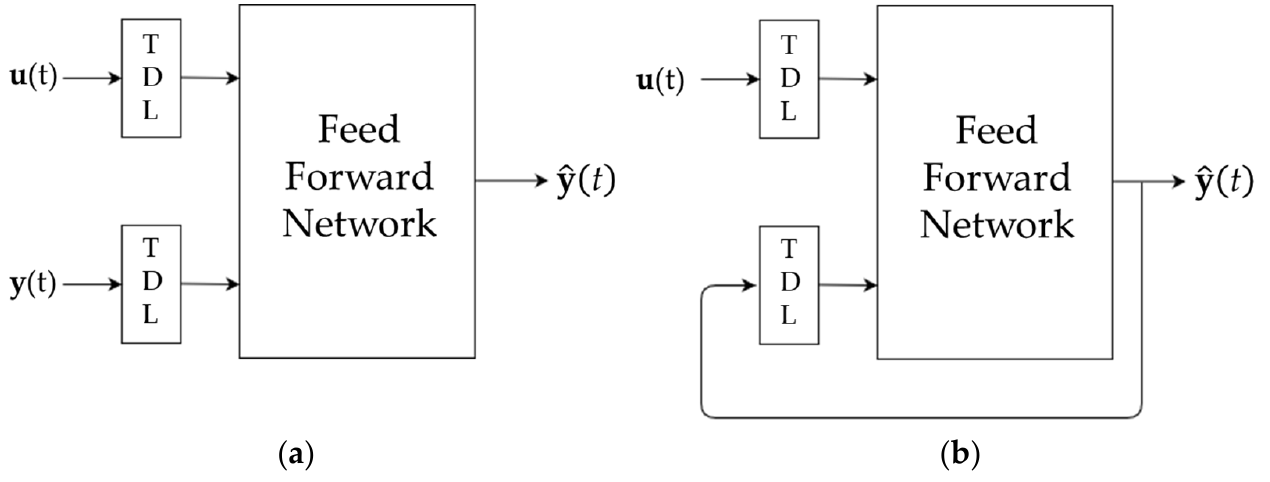
Figure 8. Architectures of the NARX neural network. ( a ) Series–Parallel. ( b ) Parallel.